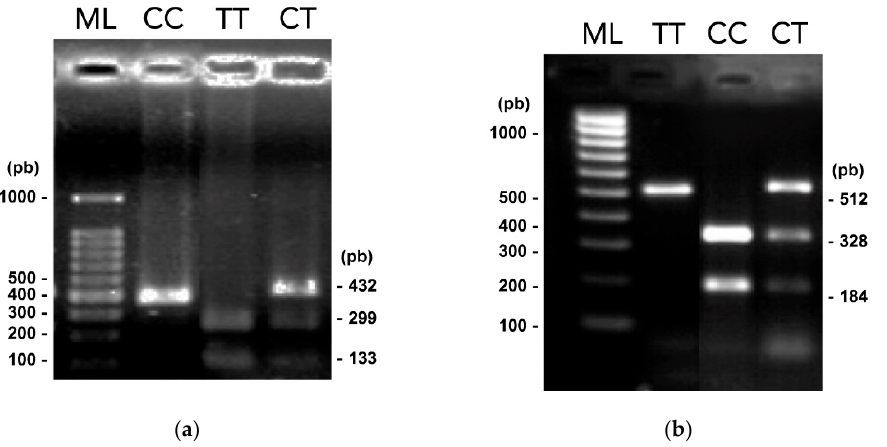
Figure 1. PCR-RFLPs results. Electrophoresis in 1.5% agarose gels of digested amplified products with Bpu10I and HpyCH4IV restriction enzymes (related to Figure S1) ( a ) Digested amplified products of SNP TOX3 rs3803662. ( b ) Digested amplified products of SNP MMP7 rs1943779. TT, CC, and CT genotypes are shown, and lane ML indicates the 100 to 1000 bp molecular gene ruler